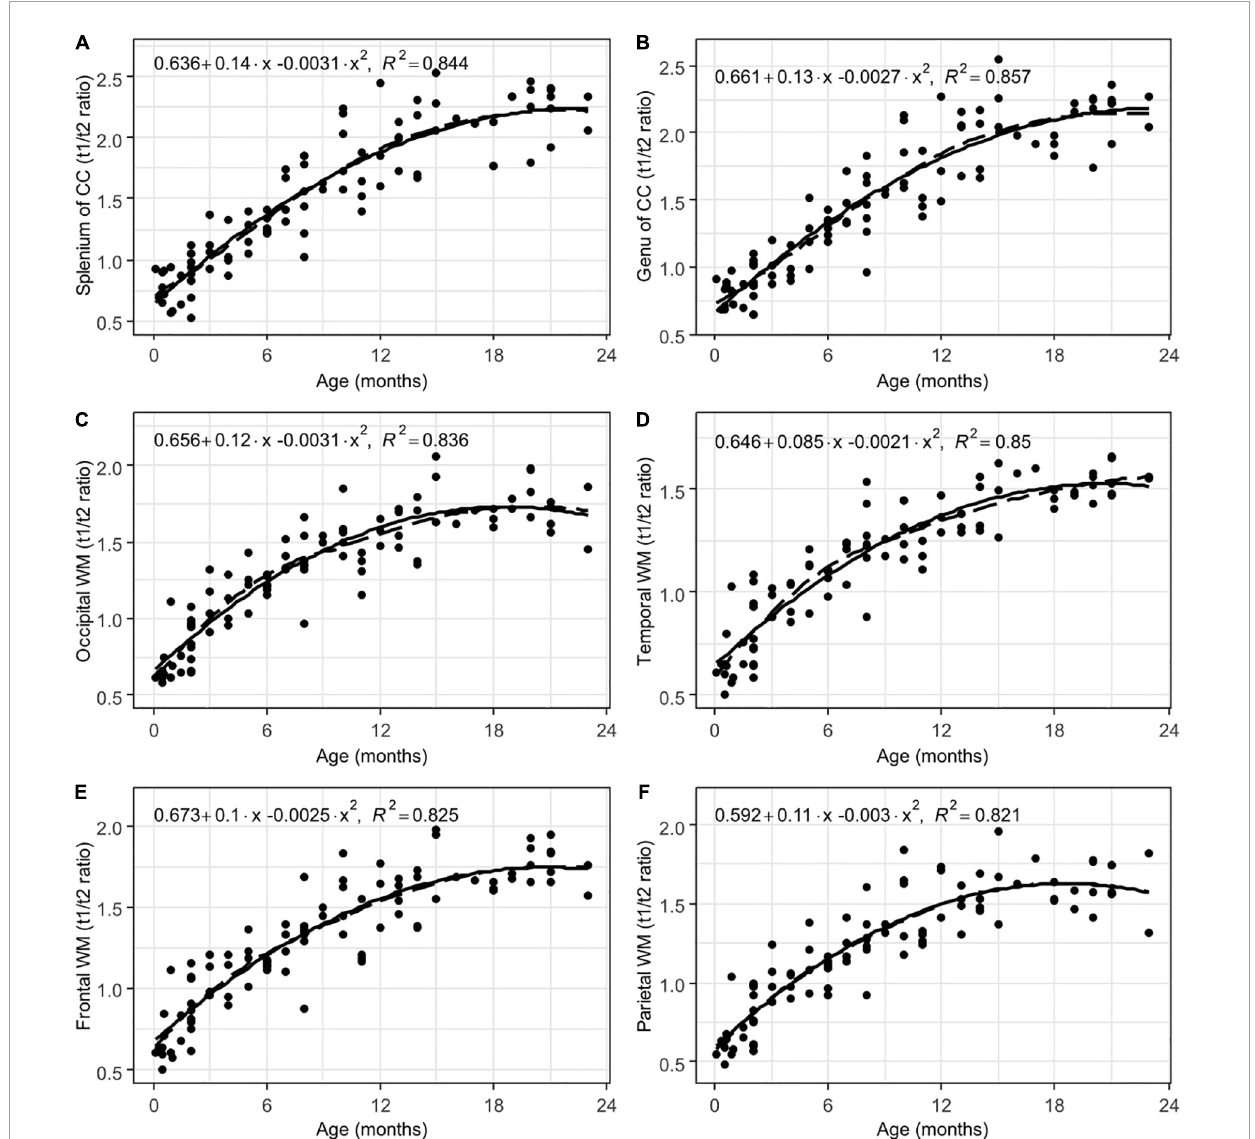
FIGURE4 Results of LOESS and 2nd order polynomial regression analyses between subjects’ age (in months) as the predictor variable and the T1w/T2w ratio values as the response variable in the splenium (A) and the genu (B) of the corpus callosum, as well as the occipital (C) , temporal (D) , and frontal (E) poles and parietal (F) white matter. The dotted line represents the LOESS regression curve, and the solid line represents the 2nd-order polynomial regression curve (adjusted p <